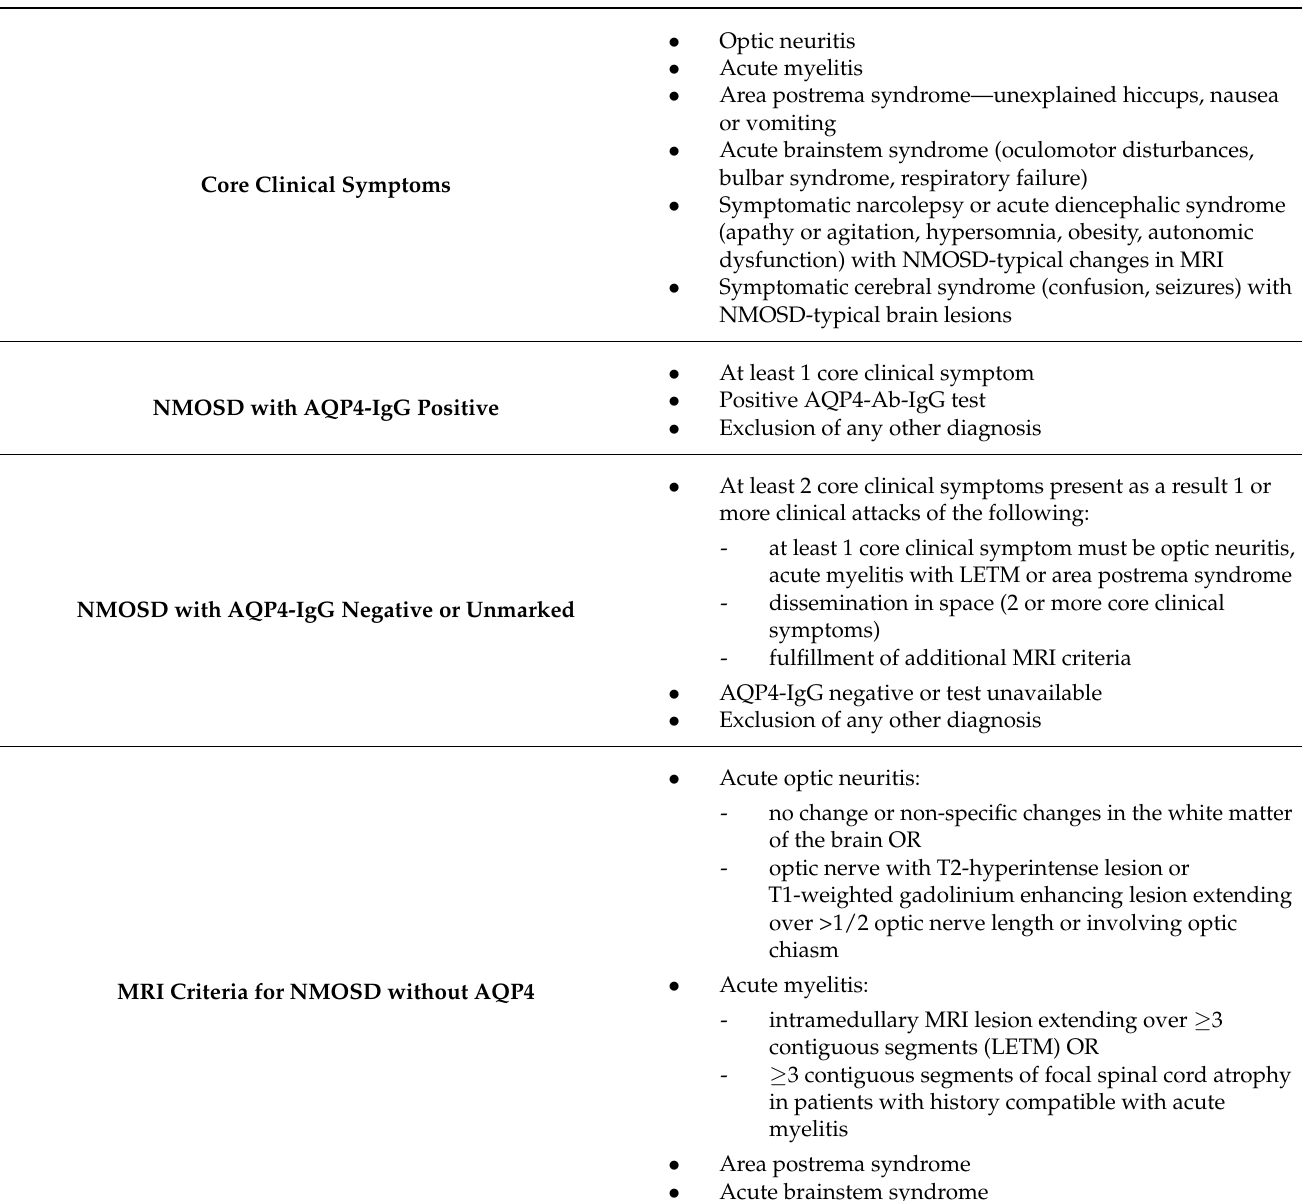
Table 1. Criteria for the diagnosis of NMOSD